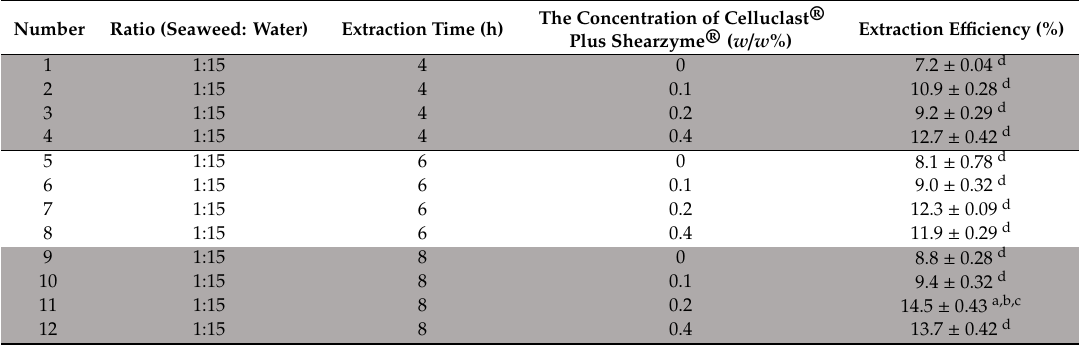
Table 1. Protein extraction conditions (ratio, extraction time and enzymes concentration (on weight basis ( w / w %)) and the average extraction e ffi ciency (%) ± standard deviations of treated Eucheuma denticulatum seaweed. Di ff erent superscripts letters in the same column indicate significant di ff erence at the confidence level of 95% ( α = 0.05; n =